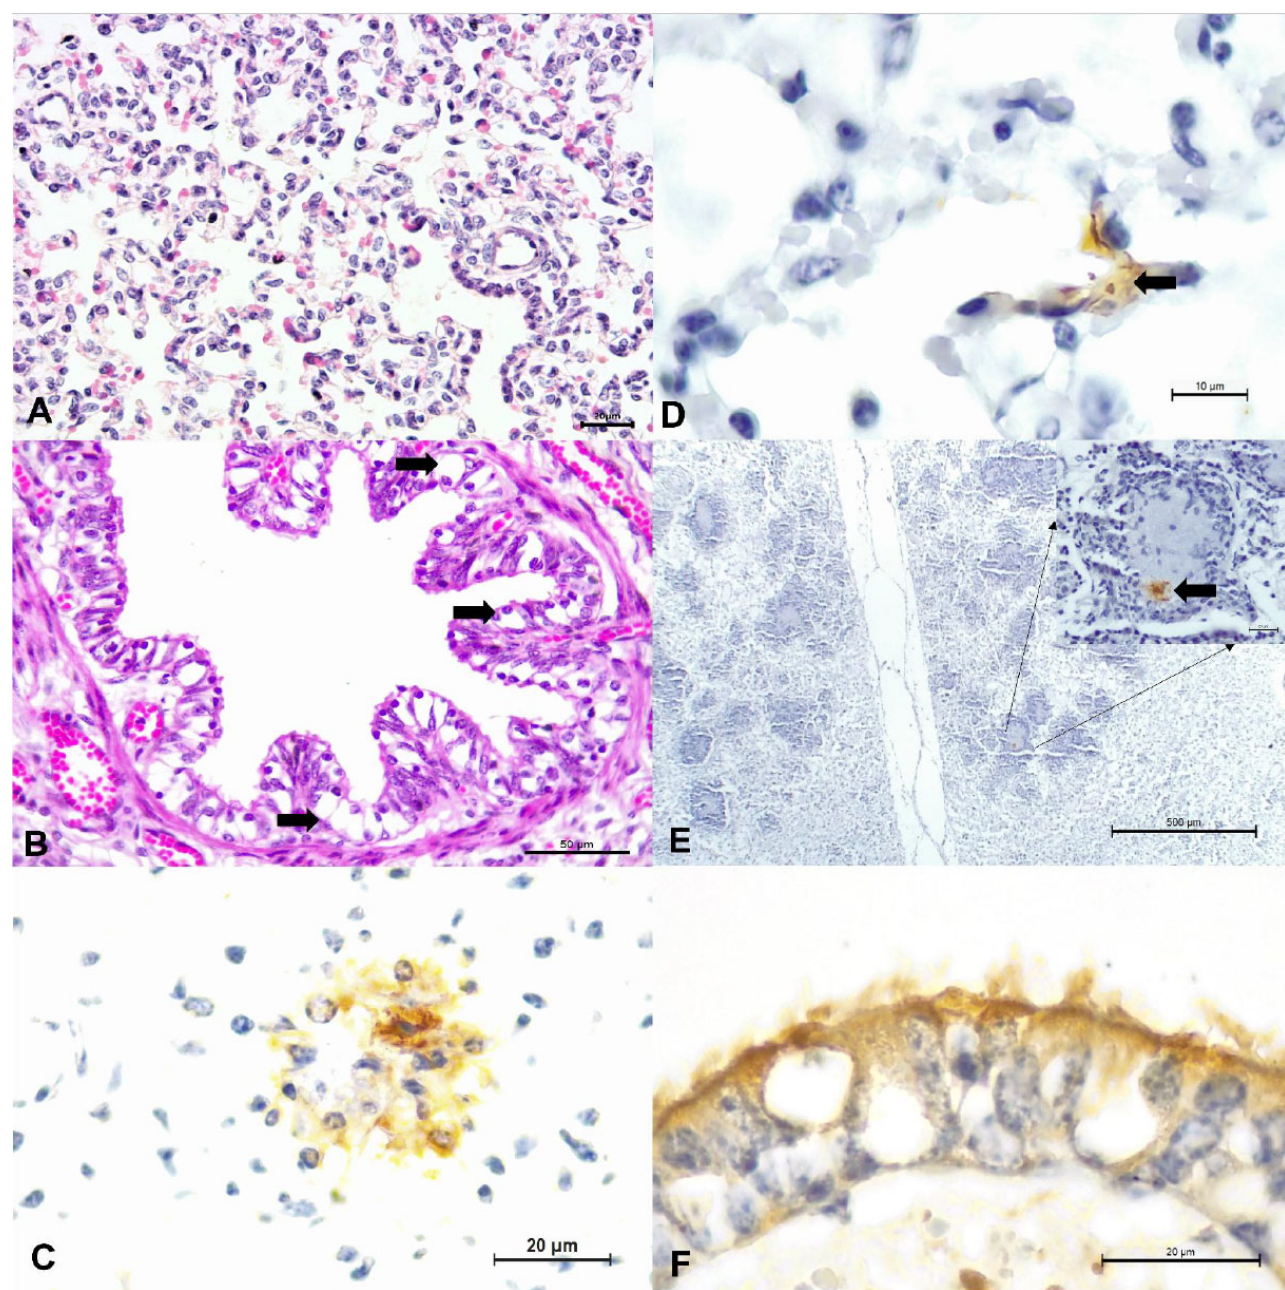
Figure 1. Principal histopathologic and immunohistochemical findings observed in fetal lungs of cattle. There is interstitial pneumonia ( A ) and degeneration (arrows) of bronchial epithelium ( B ). Observe positive intracytoplasmic immunoreactivity to antigens of BRSV ( C ), BVDV within alveolar epithelium ( D ), and within a region of suppurative bronchopneumonia ( E ); BVDV immunoreactivity is highlighted at the insert. There is positive intracytoplasmic immunoreactivity to BoAHV1 within degenerated bronchial epithelium ( F ). ( A , B ), Hematoxylin and eosin stain; ( C – F ), immunoperoxi- dase counterstained with Hematoxylin. Bars, ( A , C , F ), and insert, 20 µ m; ( B ), 50 µ m; ( D ), 10 um; ( E ), 500 µ